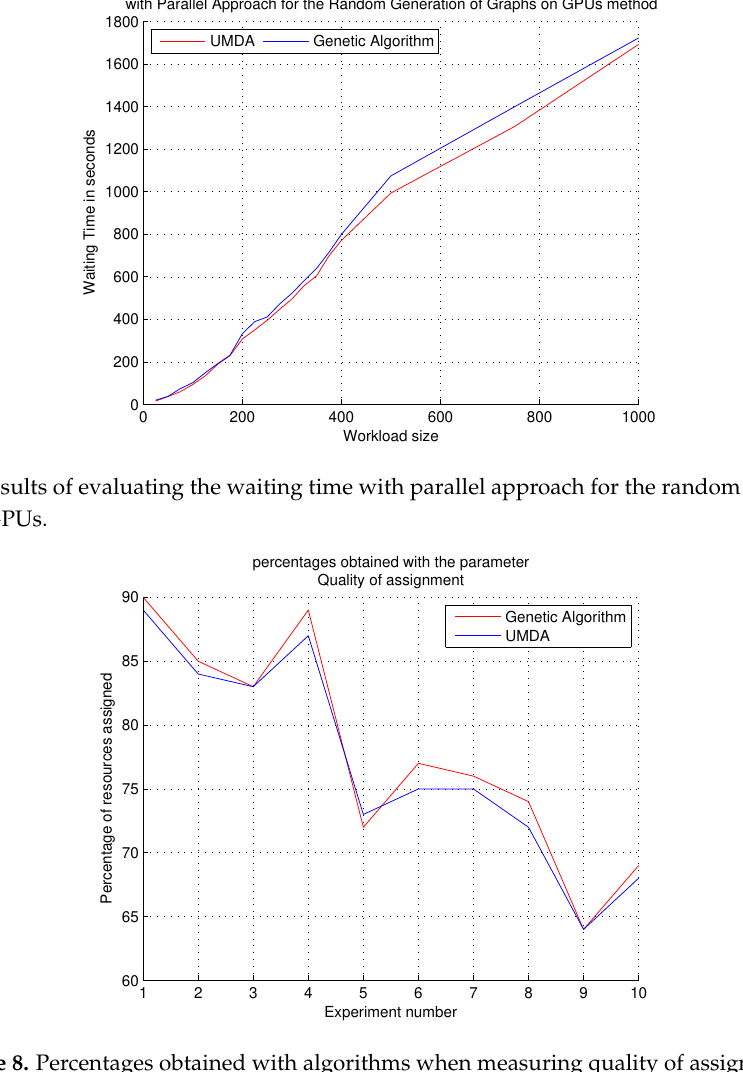
Figure 8. Percentages obtained with algorithms when measuring quality of